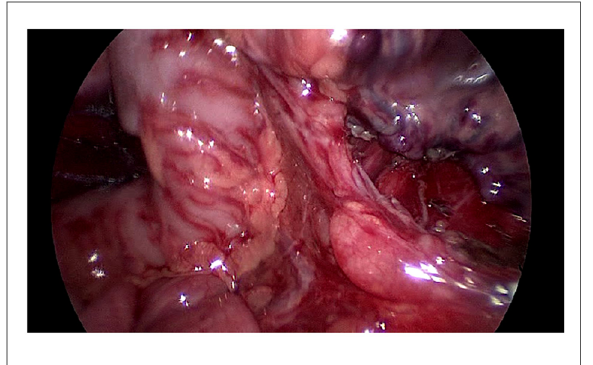
FIGURE 4 Group A: all circumference of the aganglionic rectum was mobilized.